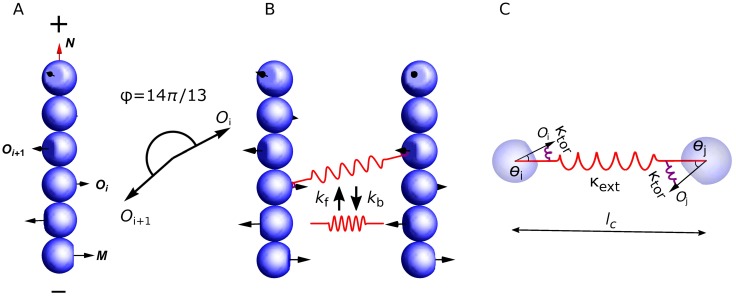
Model description.(A) Actin filaments are modeled as rigid rods made of subunits carrying an orientational vector Oi that represents the normal vector to the binding surface of the actin crosslinker. For visualization, each subunit is depicted as a sphere but is actually a disk-shape with a diameter of b = 6nm and a height of δ = 2.7nm. The orientation of a filament is described by the unit vector N, pointing from the pointed end (-) to the barbed end (+), and the first subunit’s orientational vector M = O1. Two consecutive subunits have an angle of π14/13 in their orientations. (B) Crosslinker turnover is described by stochastic formation and breakage of bonds between two actin subunits in different filaments, with rate constants kf and kb, respectively. (C) Each crosslinker is modeled as a combination of three springs, one extensional spring with stiffness κext, which characterizes the stretchiness lc between the two actin binding domains, and two torsional springs with stiffness κtor, which characterizes the flexibility of the angles θi and θj between the axis of the crosslinker (which links the centers of each subunits it is attached to) and the vector normal to the binding surface of each actin subunit in each filament (Oi and Oj).